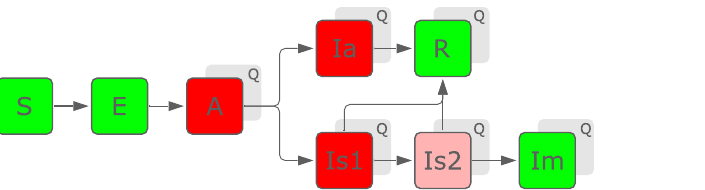
Fig 1. Network structure of the model(s). Every compartment (except S and E) has a quarantined version, transitions into which occur via testing. New infections are transmitted by individuals of the classes coloured red (with the stage Is2 being less infectious). Classes R and Im (mortalities) are no longer